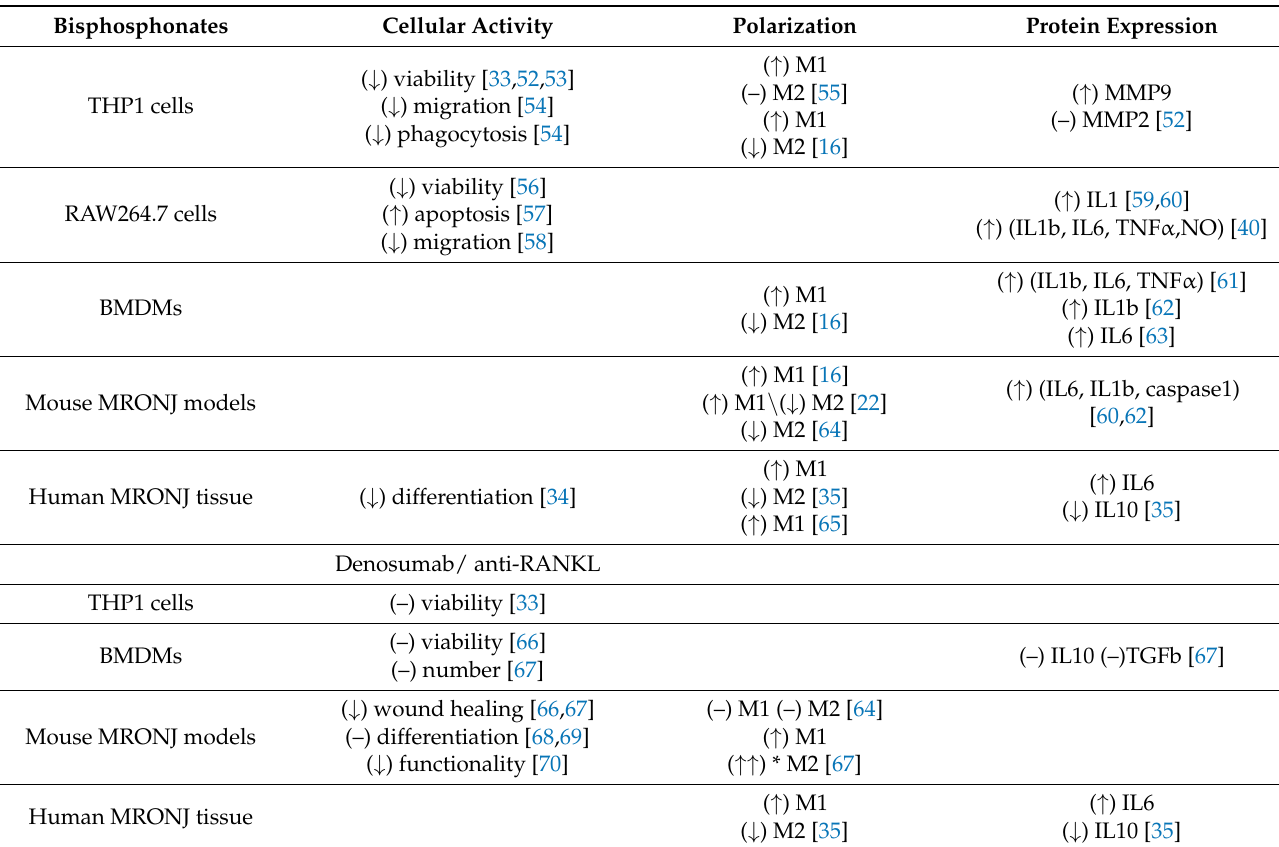
Table 1. Effect of antiresorptive medication on macrophages’